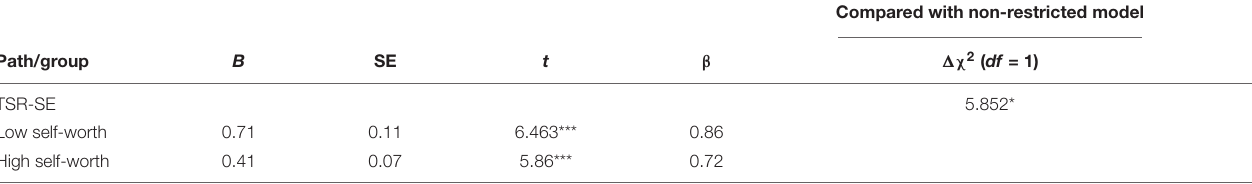
TABLE 6 | Hypothesized path comparisons among different groups: moderating